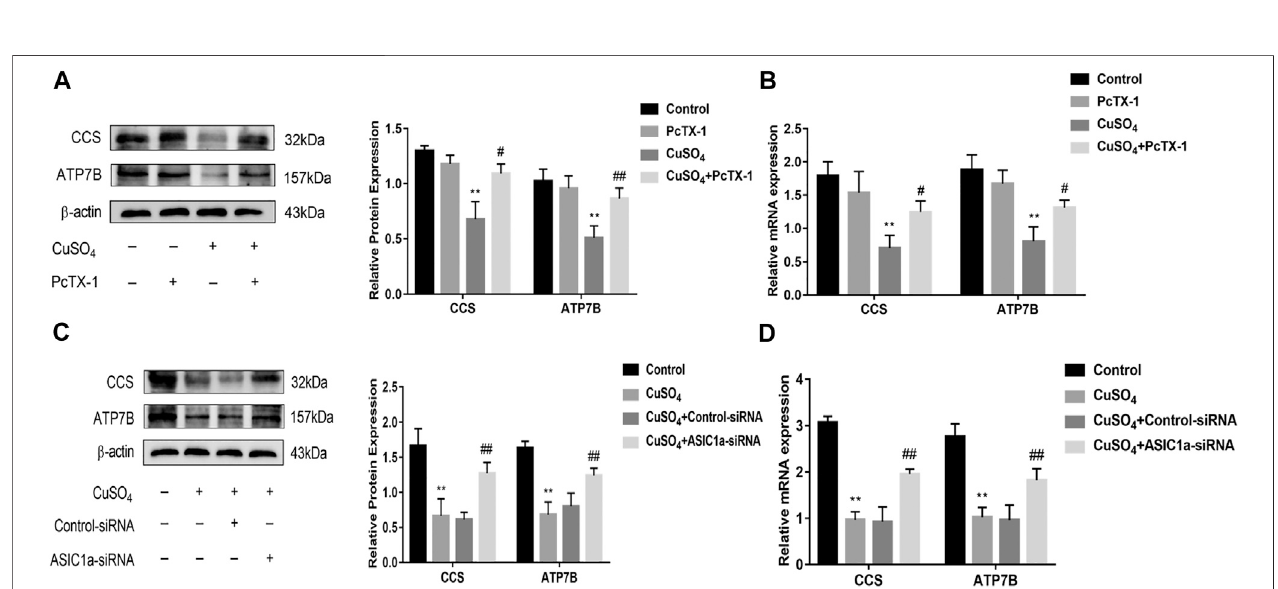
FIGURE3| TheeffectofregulatingtheexpressionofASIC1aonERSincopper-treatedHSC-T6cells (A )Westernblottinganalysisanddensitometricquanti fi cation of GRP78, and XBP1 protein levels in HSCs treated with PcTX-1; (B) mRNA levels of GRP78, and XBP1 in HSCs treated with PcTX-1 (C) Western blotting analysis and densitometric quanti fi cation of GRP78, XBP1 protein levels in HSCs transfected with ASIC1a-siRNA; (D) mRNA levels of GRP78, XBP1 in HSCs transfected with ASIC1a-siRNA.Statisticalanalyseswereperformed using t-test.Dataare expressed asthemean ± SEM( n (cid:2) 4). * p < 0.05, ** p < 0.01vs. Controlgroup; # p < 0.05, ## p < 0.01 vs. CuSO 4 group.